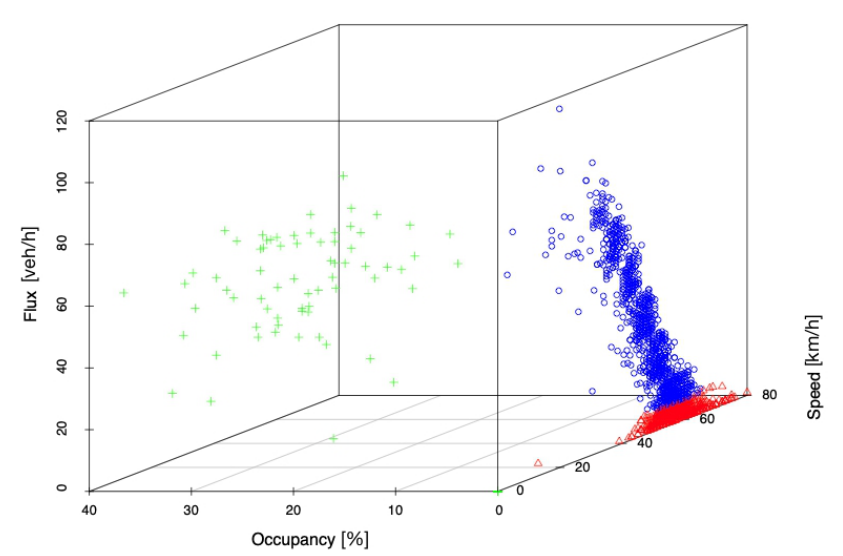
Figure A6. 3D plot of clustered Sophia Antipolis data.